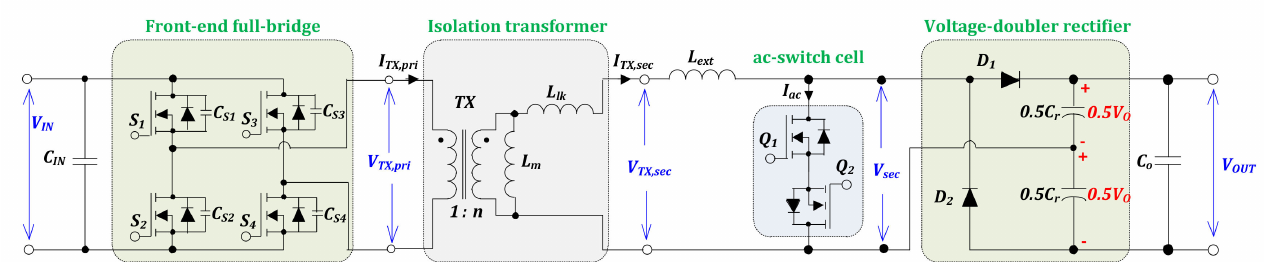
Figure 14. SRC configuration based on the ac-switch boosting technique [17].